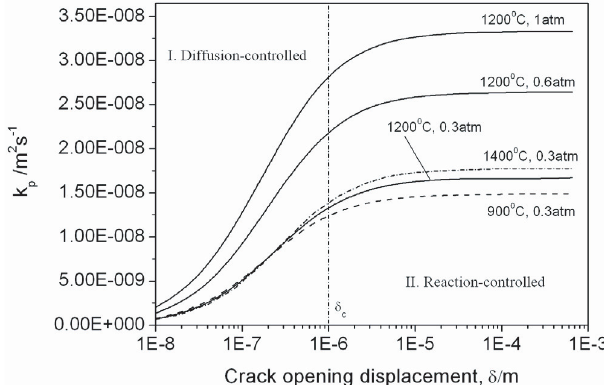
Fig. 3. Effect of crack opening displacement δ on recession rate K p